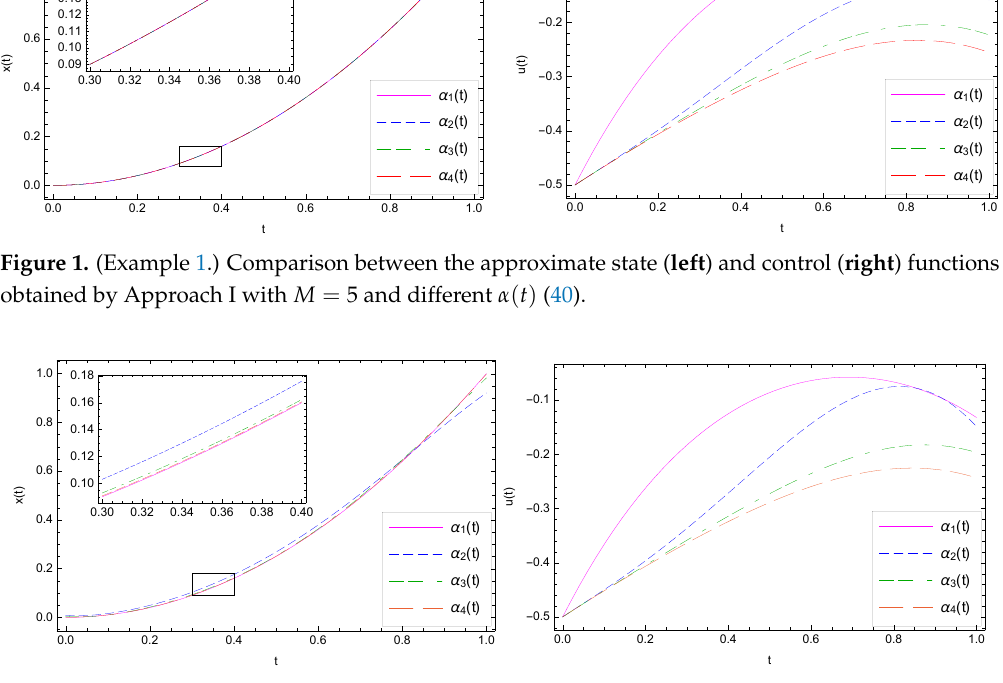
Figure 2. (Example 1.) Comparison between the approximate state ( left ) and control ( right ) functions obtained by Approach II with M = 5 and different α ( t ) (40). Table 2. (Example 1.) Numerical results for the performance index with M = 5 and different α ( t )